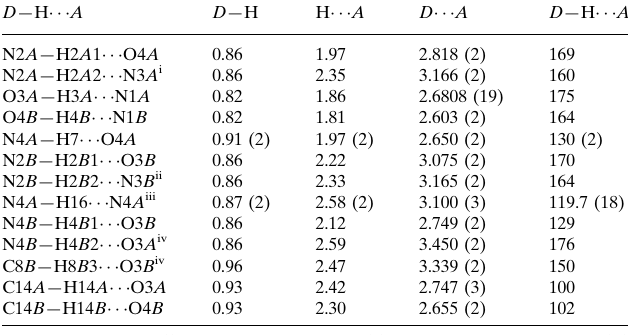
Hydrogen-bond geometry (A˚ , (cid:2)